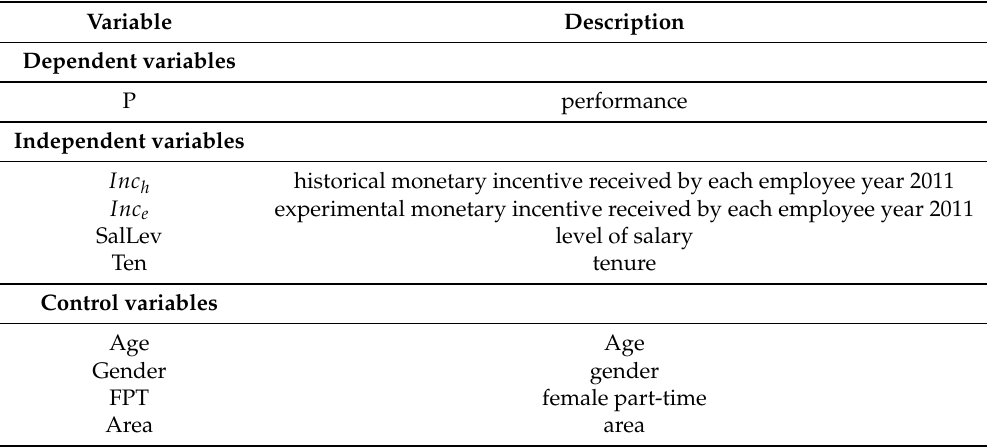
Table 6. Variables of the linear regression model described in Equation (6).